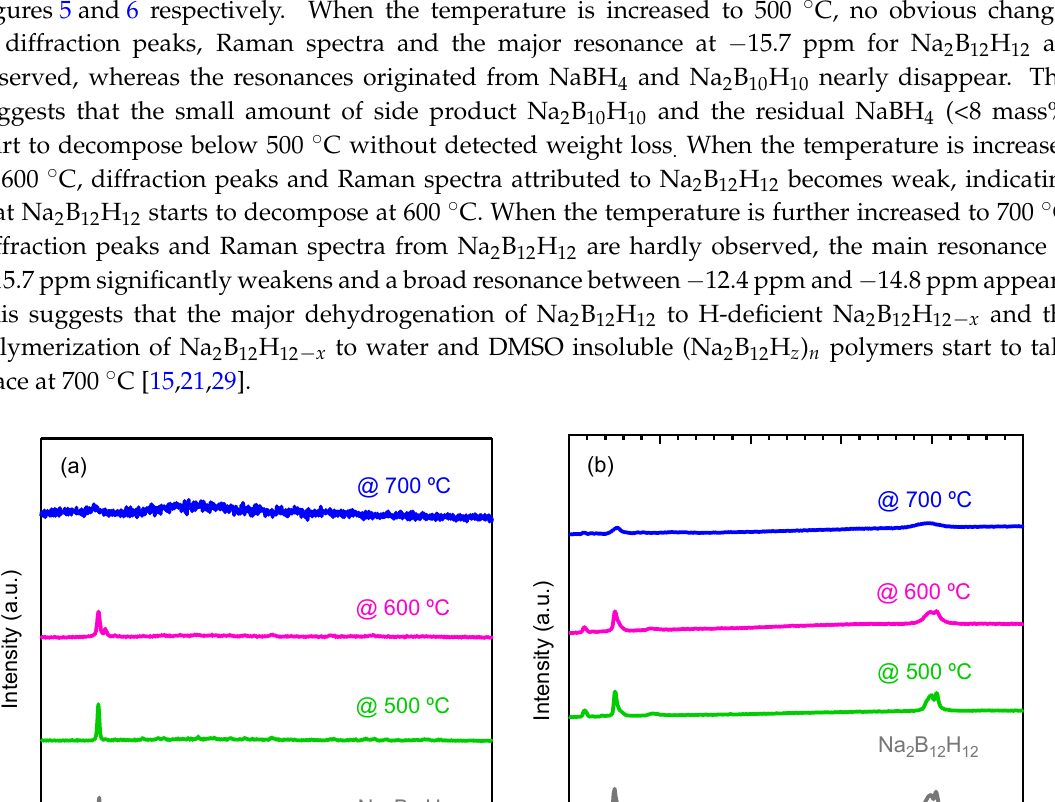
Figure 5. Ex-situ ( a ) XRD patterns and ( b ) Raman spectra of anhydrous Na 2 B 12 H 12 as synthesized and heated up to respective temperatures.